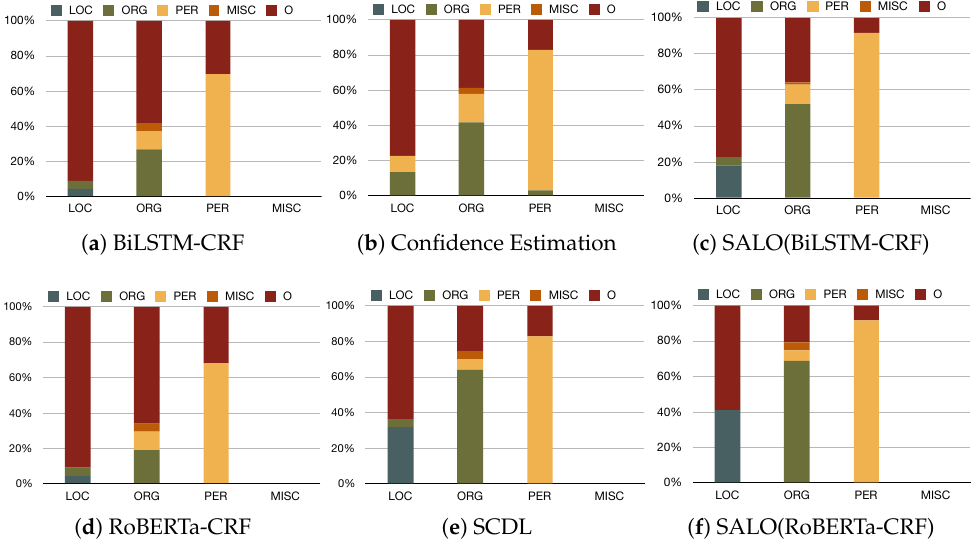
Figure 4. Case Study. The horizontal axis represents the true entity type. The segments in a bar describe the portions of the entities being classified into different entities. The base NER model of ( a – c ) is BiLSTM, while that of ( d – f ) is